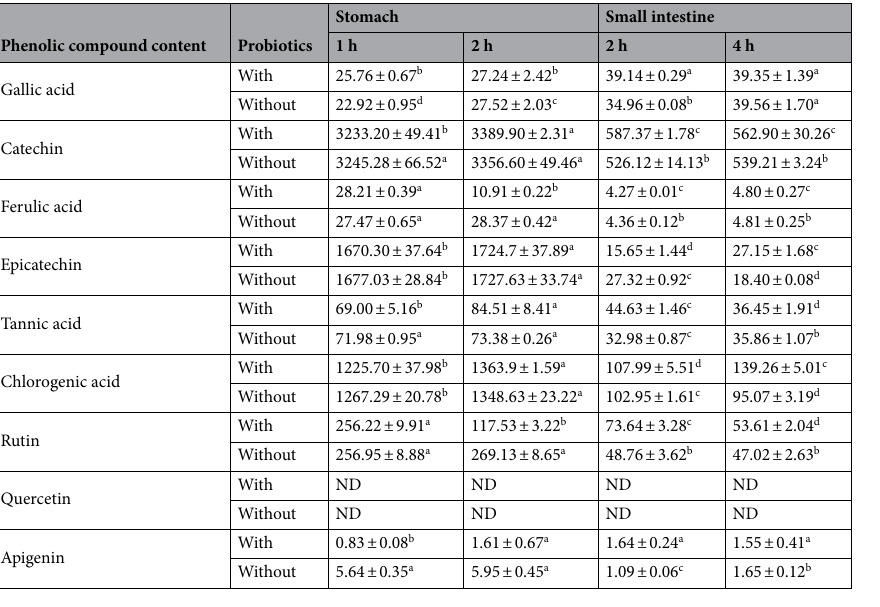
Table 4. Phenolic compound content (ppm) of green vegetable tablets with/without probiotics when passing through the simulated early and middle digestive systems. *mean ± standard deviation. ND: not detected. a,b,c,d Different superscript letters (within same row) indicate significant differences ( p ≤